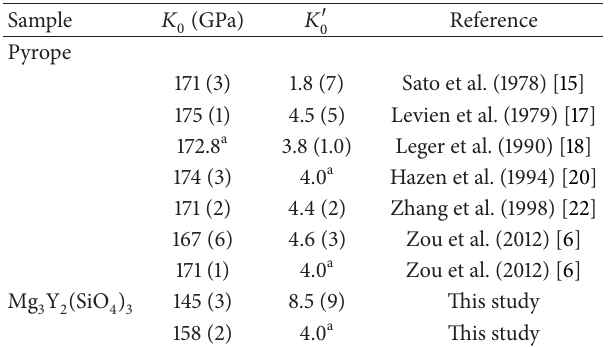
Table 3: Elastic parameters derived from the